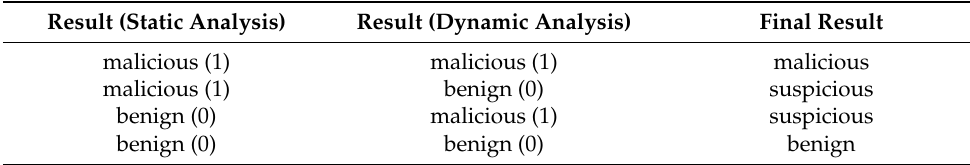
Table 13. Obtaining the final result of the classification concerning a file.